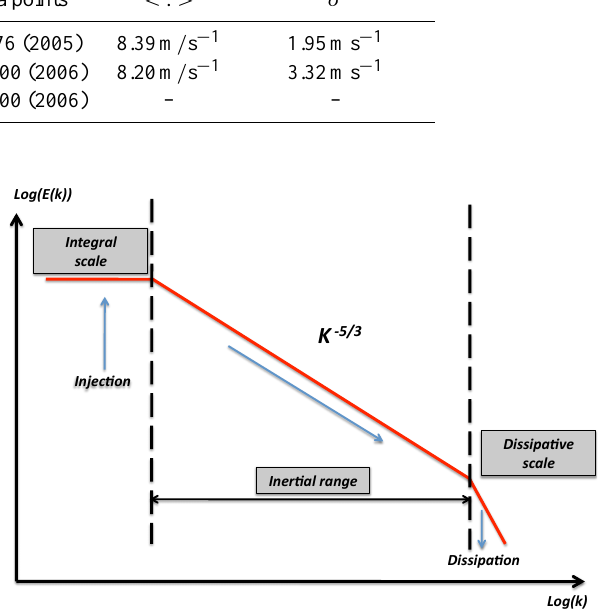
Fig. 2. An illustration of the Kolmogorov quasi-equilibrium ener- getic cascade in the inertial